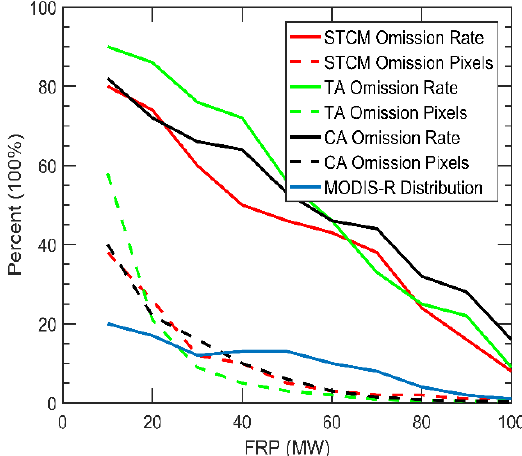
Figure 6. Details of three methods of Advanced Himawai Imager (AHI) active fire pixel omissions with respect to MODIS. “TA” and “CA” denote the temporal algorithm and contextual algorithm for forest fire detection respectively. “MODIS-R” denotes the MODIS active fire observations resampled onto the AHI imaging grid cell.